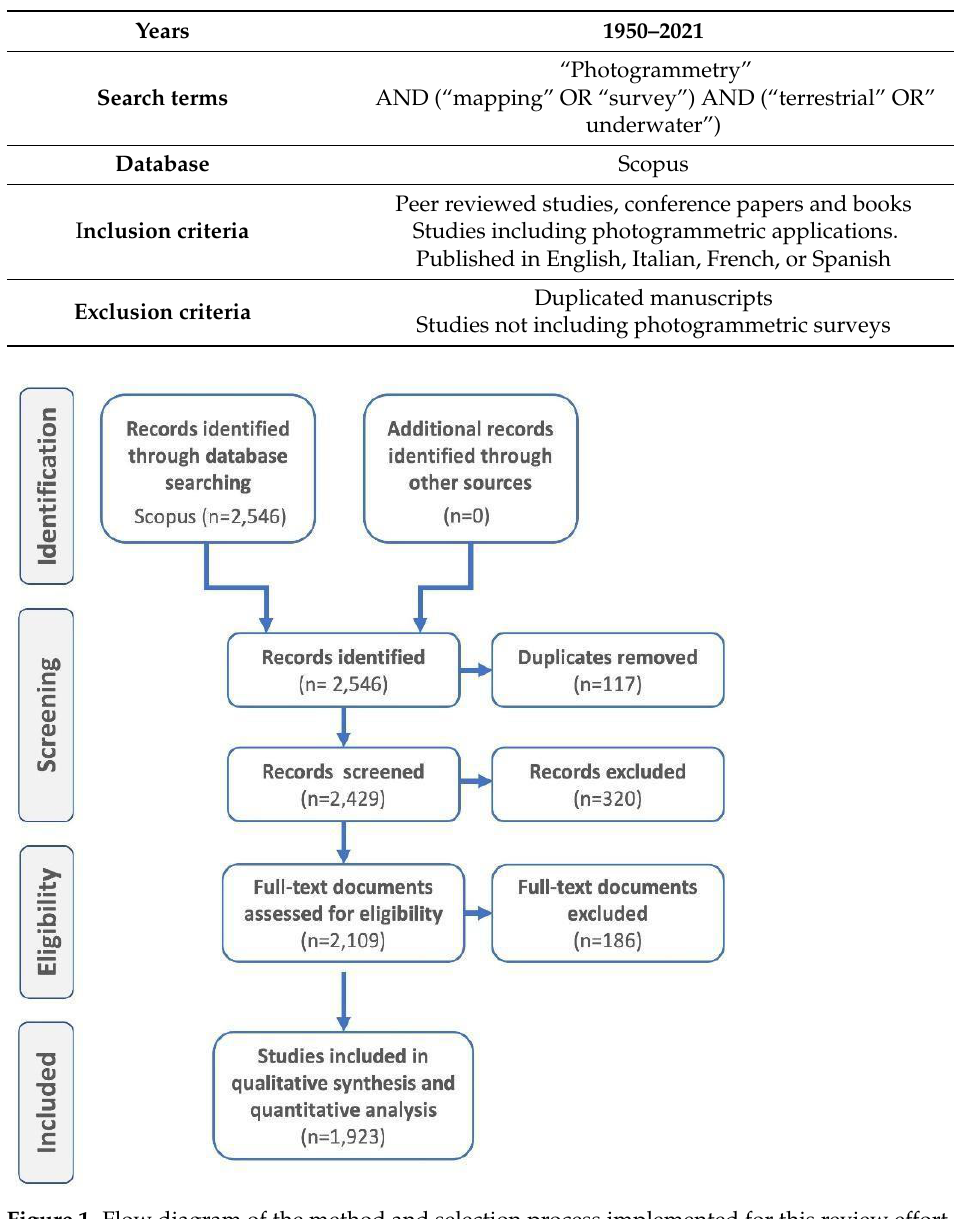
Table 1. Research procedure and inclusion and exclusion criteria.